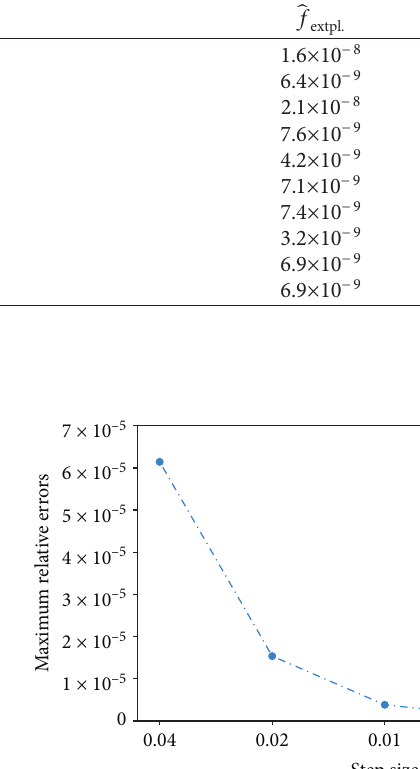
Table 10: Maximum relative errors and convergence orders of 􏽢 f